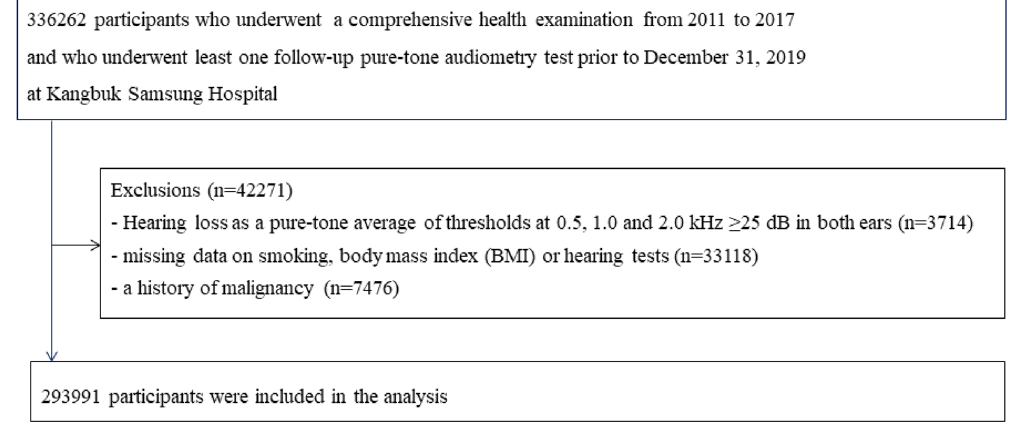
Figure 1. Flow chart of study